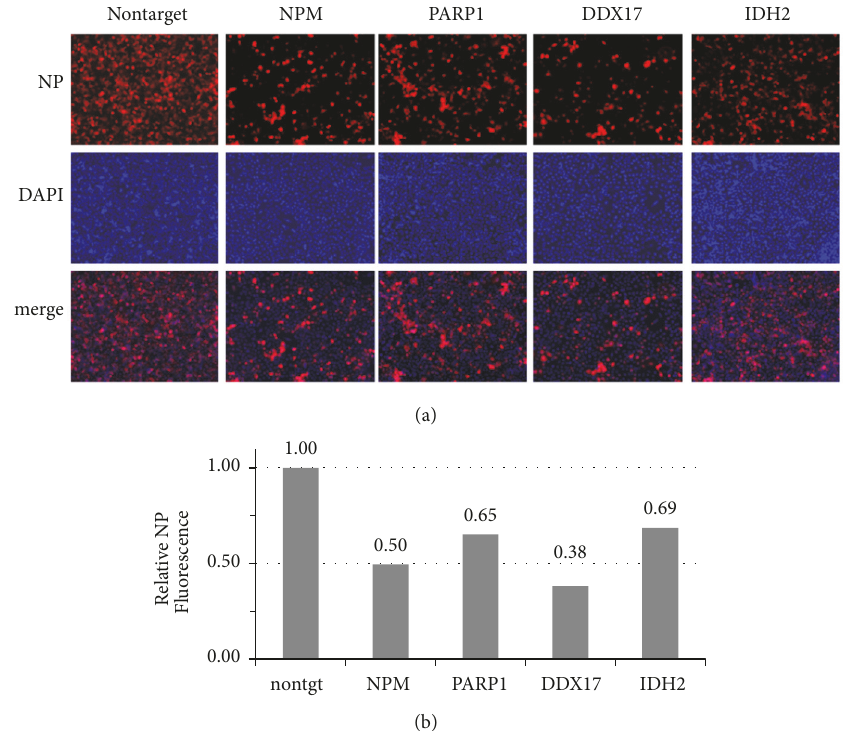
Figure 2: PARP1 is required for synthesis of influenza nucleoprotein. (a) Host factors were targeted by RNA interference in human lung A549 cells, and after 36h knockdown, cells were infected with low-path, avian-derived influenza virus strain A/Viet Nam/1203/04 (H5N1) HALo (MOI = 0.1). Host factors targets: nucleophosmin 1 (NPM), PARP1, DEAD-box RNA helicase 17 (DDX17), and inosine monophosphate dehydrogenase 2 (IMPDH2, here shortened to IDH2), in comparison to scrambled negative control siRNA (nontarget). (b) Mean, normalized relative fluorescence intensity of total NP immunofluorescence in images quantified by (Alexa 555nm) fluorescent microscopy. siRNA targets are shown on horizontal